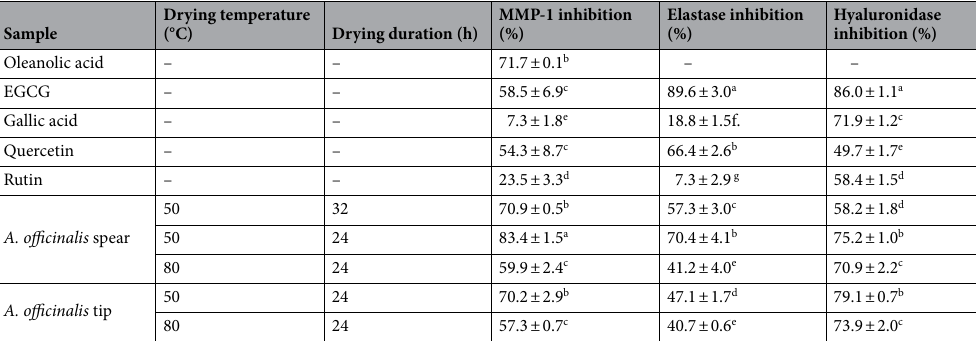
Table 3. Inhibitory activities of A. officinalis extracts on MMP-1, elastase, and hyaluronidase. The concentration of A. officinalis extracts used in the test was 0.1 mg/ml. Data presented as mean ± SD (n = 3) Different letters, a, b, c, d, e, f, and g. denote significant differences in antioxidant activities among various A. officinalis extracts, whereas similar letters denote non-significant differences at p < 0.05.